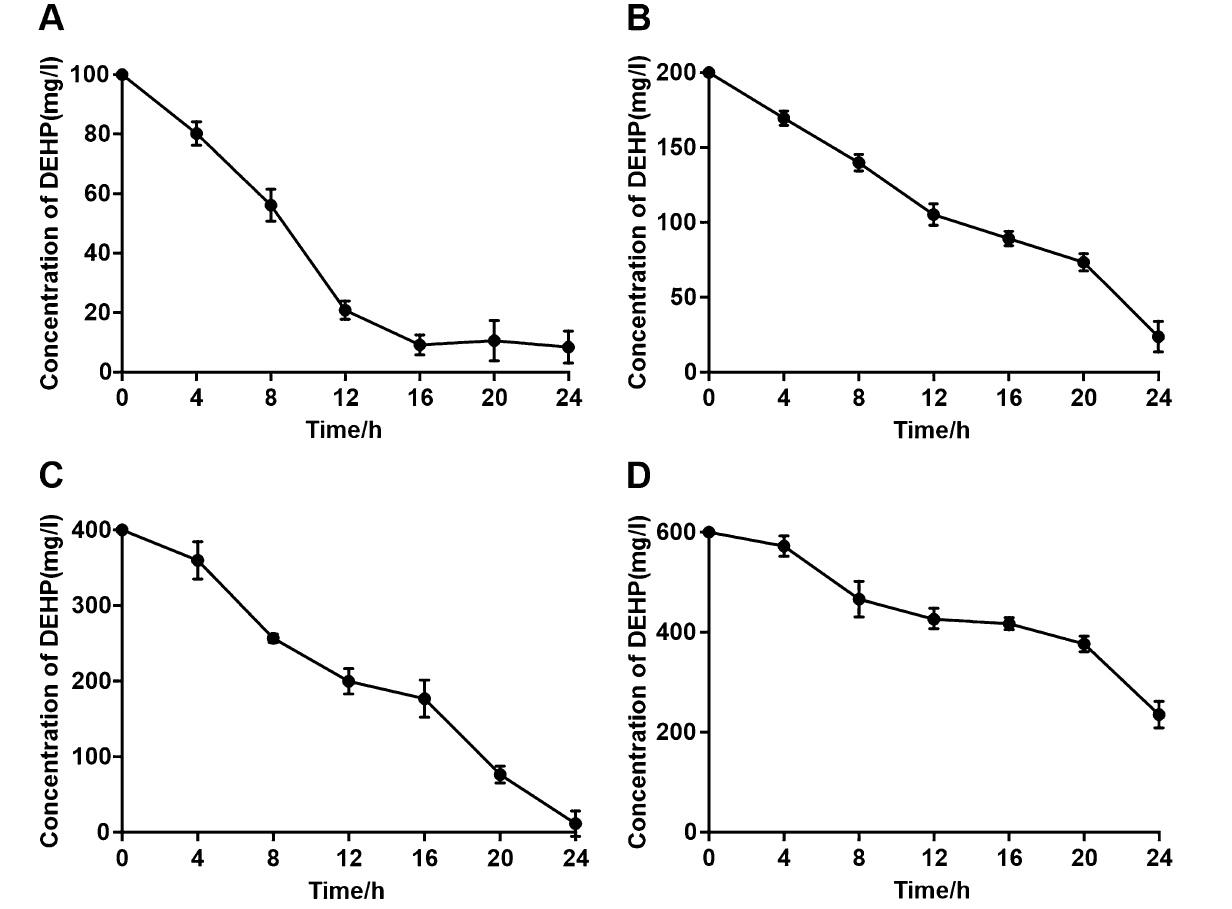
Figure 3. Degradation of DEHP by LMB-7 in MSM containing different initial DEHP concentrations. Initial concentrations of DEHP were 100, 200, 400 and 600 mg/L, respectively, for ( A – D ). Data are the mean ± SD of at least three independent experiments.